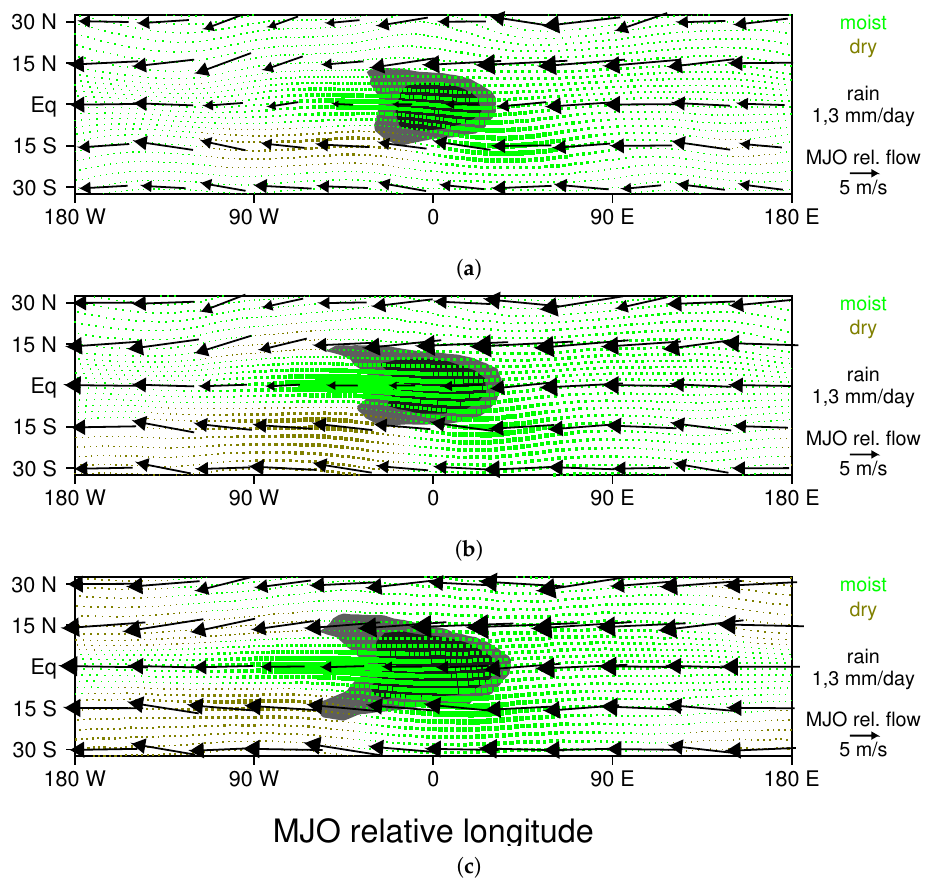
Figure 10. Moisture change in near-surface parcels advected by MJO relative low-level flow for seven days, with green (brown) indicating moistening (drying), and the size of the box illustrating the amplitude of the change: ( a ) control simulation; ( b ) 3 K warming experiment; and ( c ) 7 K warming